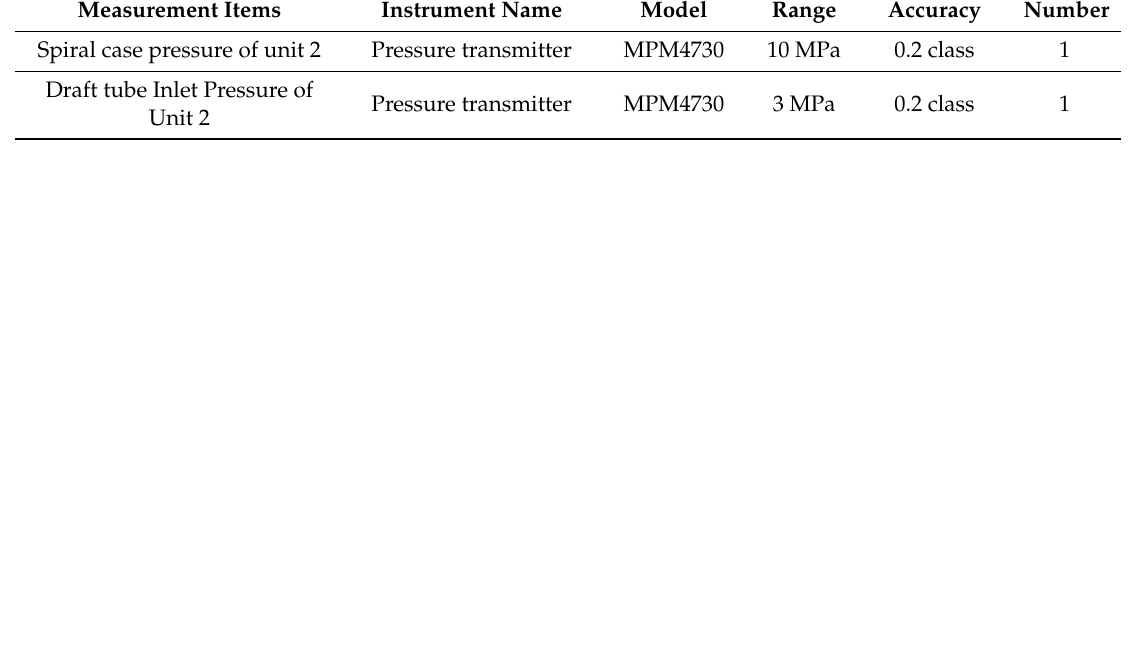
Table 4. Pressure sensor parameters for